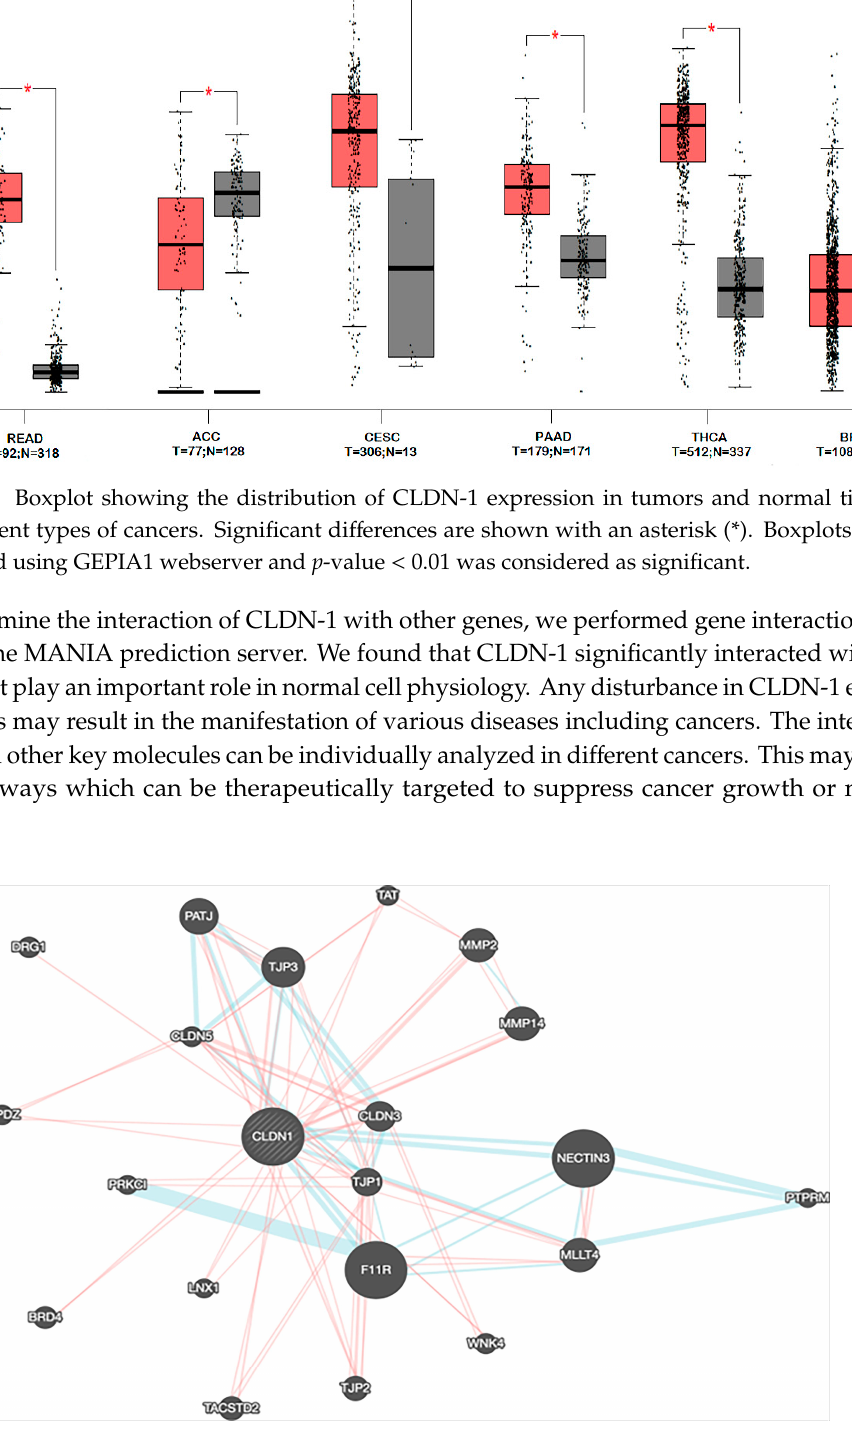
Figure 6. CLDN-1 interaction network using the Gene MANIA prediction server.